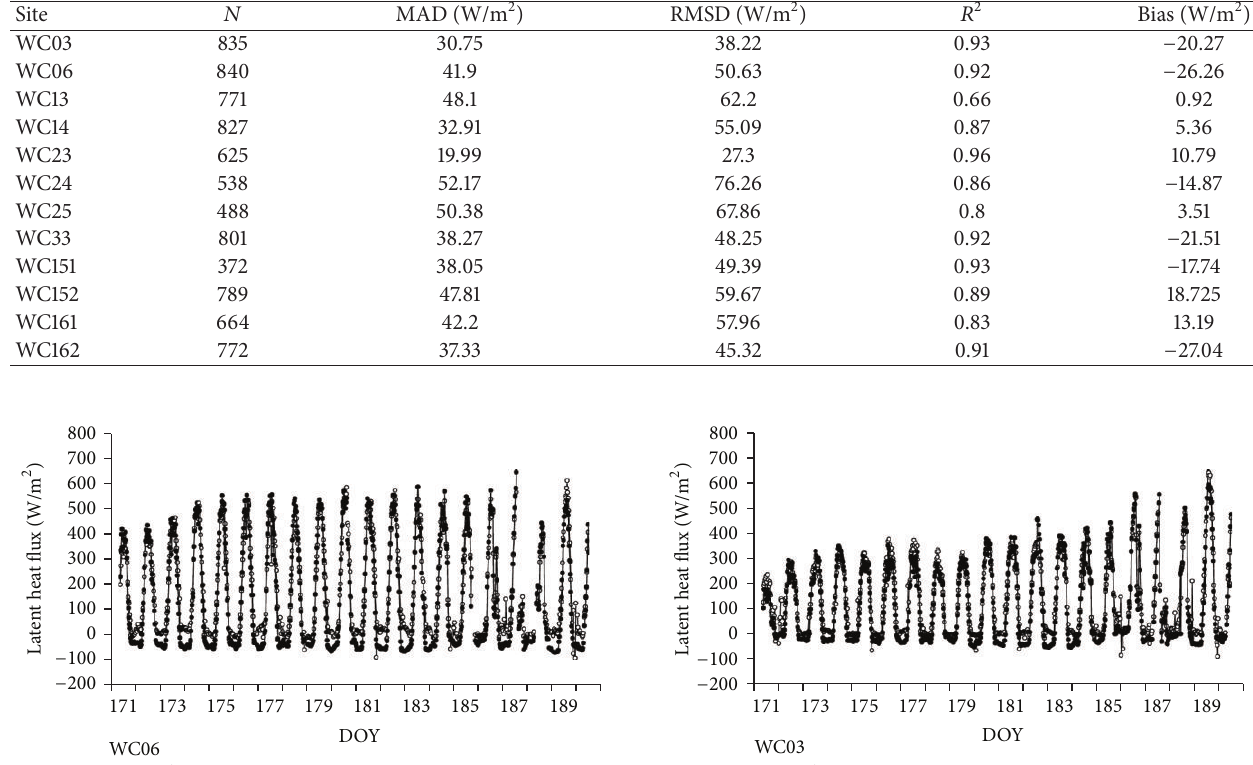
Table 2: Quantitative measures of model performance.